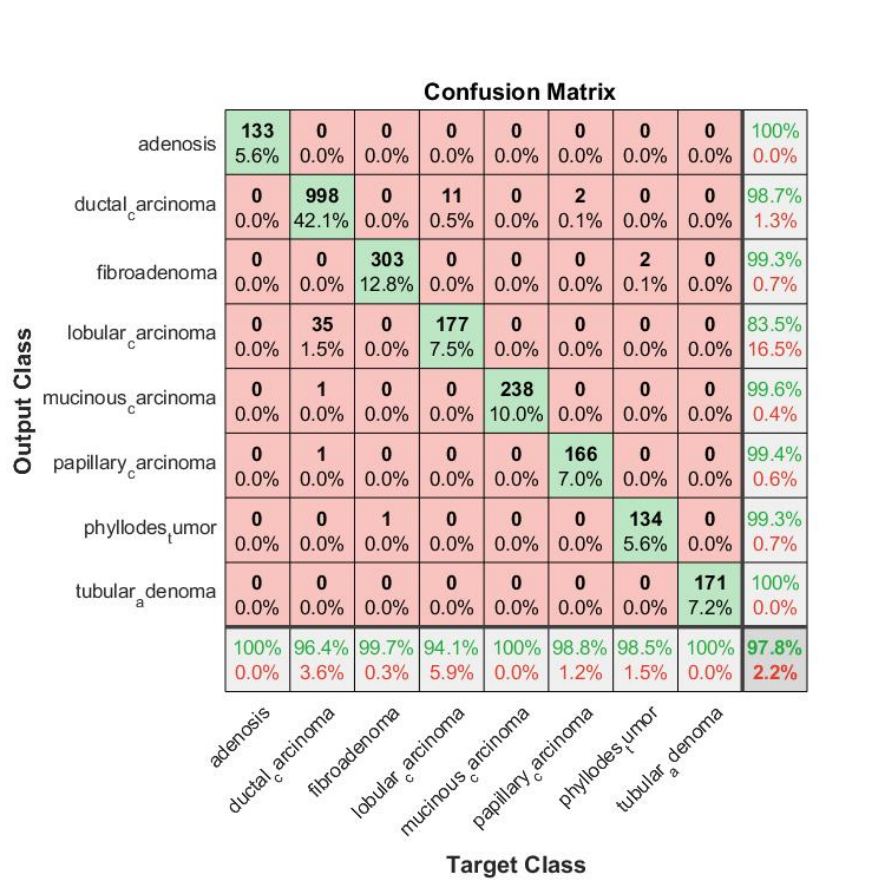
Figure 17. Confusion matrix displaying the performance of the proposed ensemble